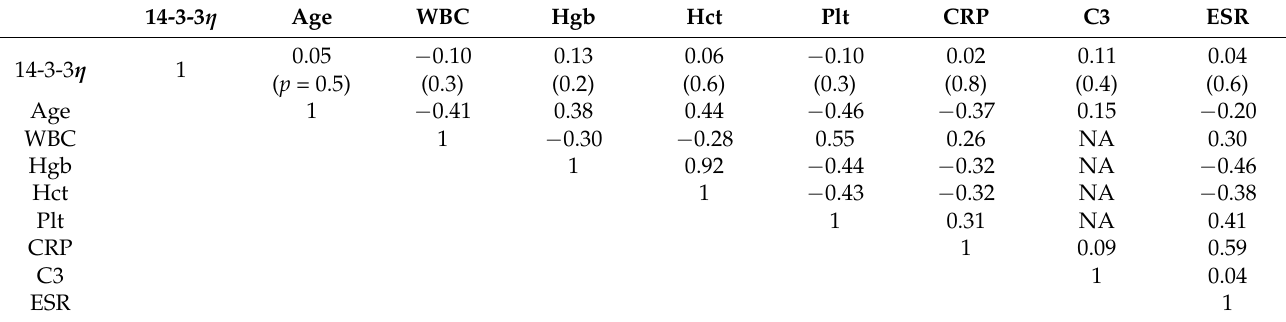
Table 5. Spearman’s Rank Correlation ( ρ ) for All 14-3-3 η .